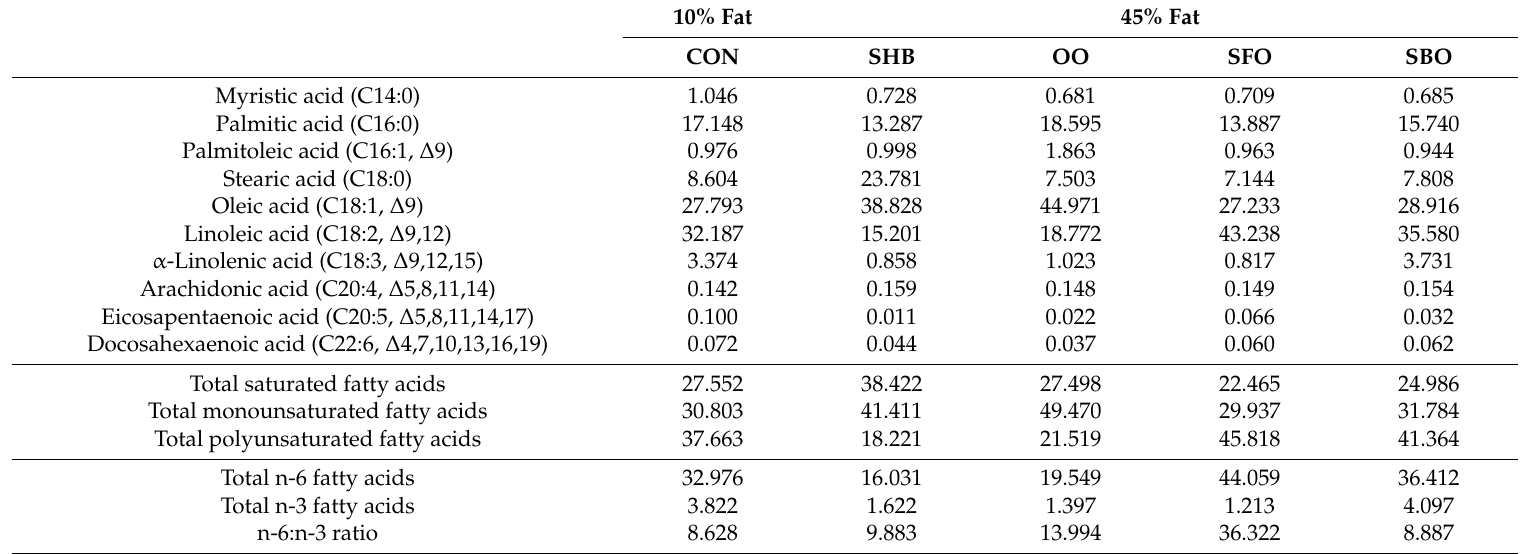
Table 1. Fatty acid composition of the experimental diets (% of fatty acids) 1